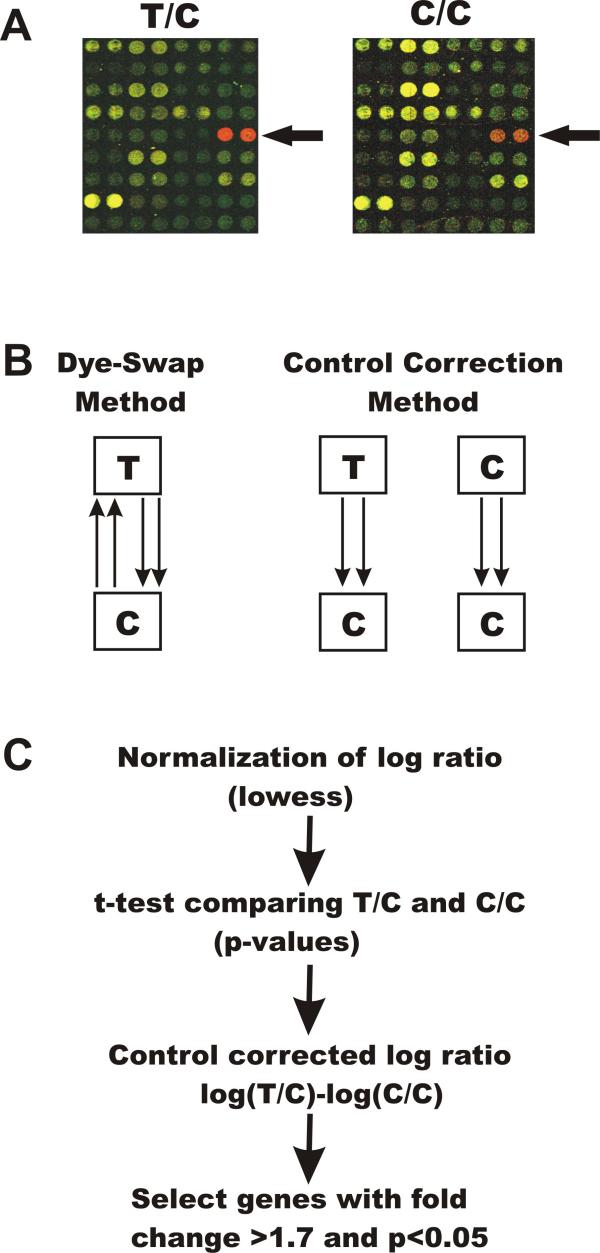
(A) Highly reproducible systematic errors from gene-dye interactions. The arrows demonstrate intense red dye labeling for a given gene spotted in duplicate both for the T/C slide where the treated sample is labeled with red dye (Cy5) and control sample is labeled with green dye (Cy3), as well as in the C/C slide where the same sample is labeled both red and green. (B) Experimental designs. Two different experimental methods were compared: A dye-swap approach, where the dye color is reversed for T/C hybridizations, and a "control correction" design, where T/C and C/C hybridizations are performed without reversing the dyes. T denotes the neuregulin treated cells, while C denotes the untreated, control cells. Each arrows represent a replicate and the tails of the arrows indicate cy5 labeling and the heads indicate cy3 labeling. (C) Data processing flow chart for the control correction method.